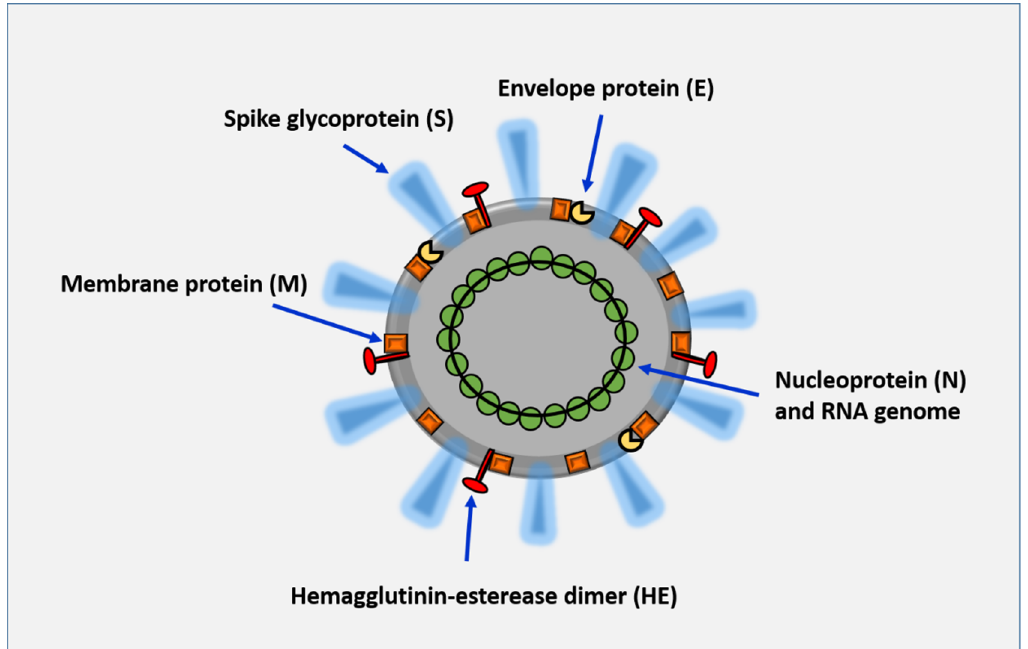
Figure 1. Structure of the SARS-CoV-2 virus. The virus is formed by an envelope membrane associated with the following structural proteins: spike protein (S), which mediates binding to the host cell receptors and considered a critical target for the induction of antibodies capable of neutralizing the virus; hemagglutinin-esterase dimer (HE), which acts as a potent mediator of attachment and destruction of sialic acid receptors on the host cell surface; a membrane glycoprotein (M), which is important to generate the virus; and the envelope protein (E), which adheres to the M protein to form the viral envelope. The viral structure also comprises a nucleocapsid protein (N) that, along with the RNA genome, produces the nucleocapsid.